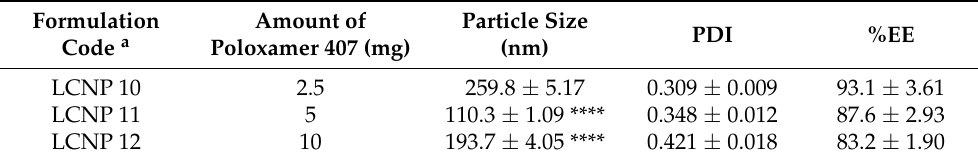
Table 3. Effect of the amount of Poloxamer 407 on the particle size, PDI, and %EE of RTG-LCNP (n = 3). One-way ANOVA with Tukey test was applied. p -value ≤ 0.05 was considered significant. Formulation